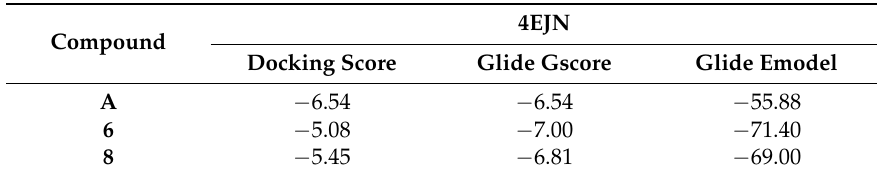
Table 5. Docking score (kcal/mol), glide gscore (kcal/mol), and glide emodel (kcal/mol) results of compounds A , 6 , and 8 for Akt enzyme (PDB code: 4EJN).